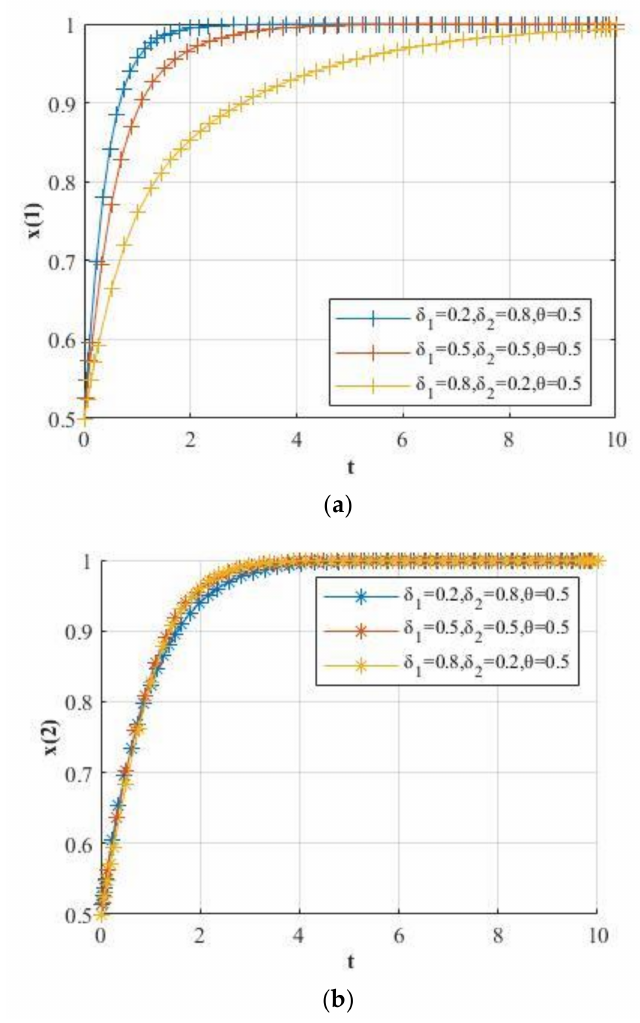
Figure 13. ( a ) While changing δ 1 , δ 2 , and θ = 0.5, evolution diagram of government’s supervision option. ( b ) While changing δ 1 , δ 2 , and θ = 0.5, evolution diagram of platform’s supervision